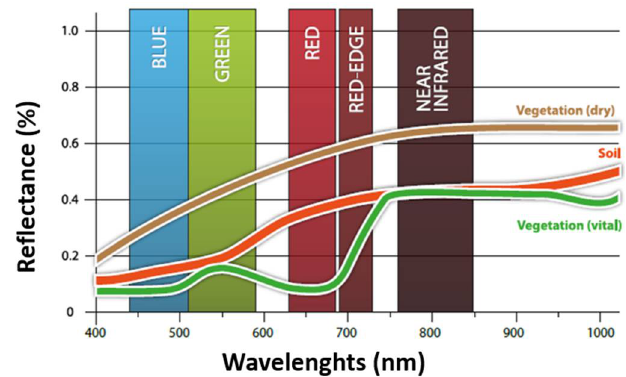
Figure 6. RapidEye spectral features and spectral signatures of soil, vital vegetation, and dry vegeta- tion.